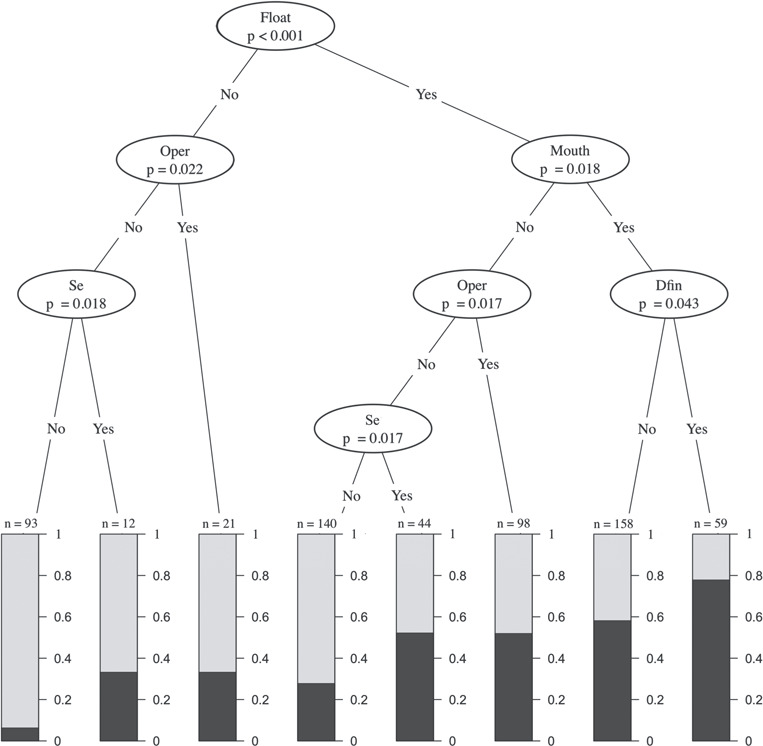
A conditional inference tree examining the impacts of the RCI score on probable mortality by using barotrauma and impairments as explanatory variables based on model g4. Monte Carlo corrected P values represent the deviation from the null hypothesis and are the base for the decision node selection. The branches are divided by ‘yes’ (impaired) or ‘no’ (unimpaired). The terminal nodes are represented by graphs where probable mortality is dark grey. Abbreviations: Float = fish floating; Se = stomach eversion; mouth = mouth movement; Oper = operculum reflex; Dfin = dorsal fish movement